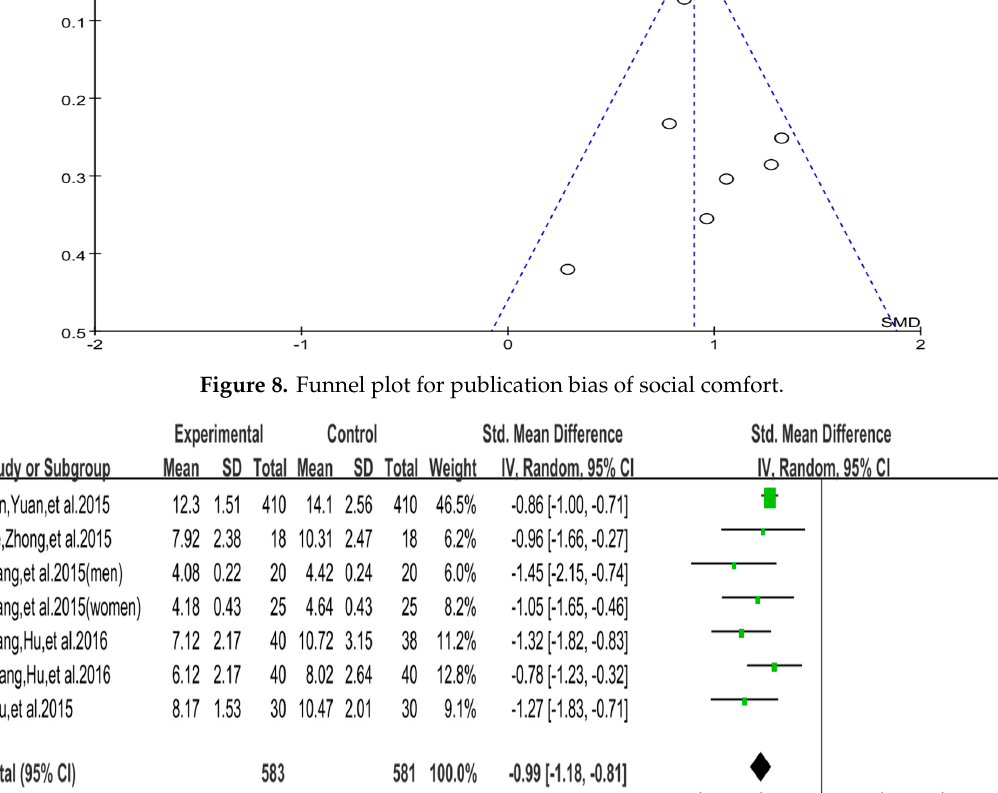
Figure 9. E ff ect of exercises on social comfort. Figure 9. Effect of exercises on social comfort.